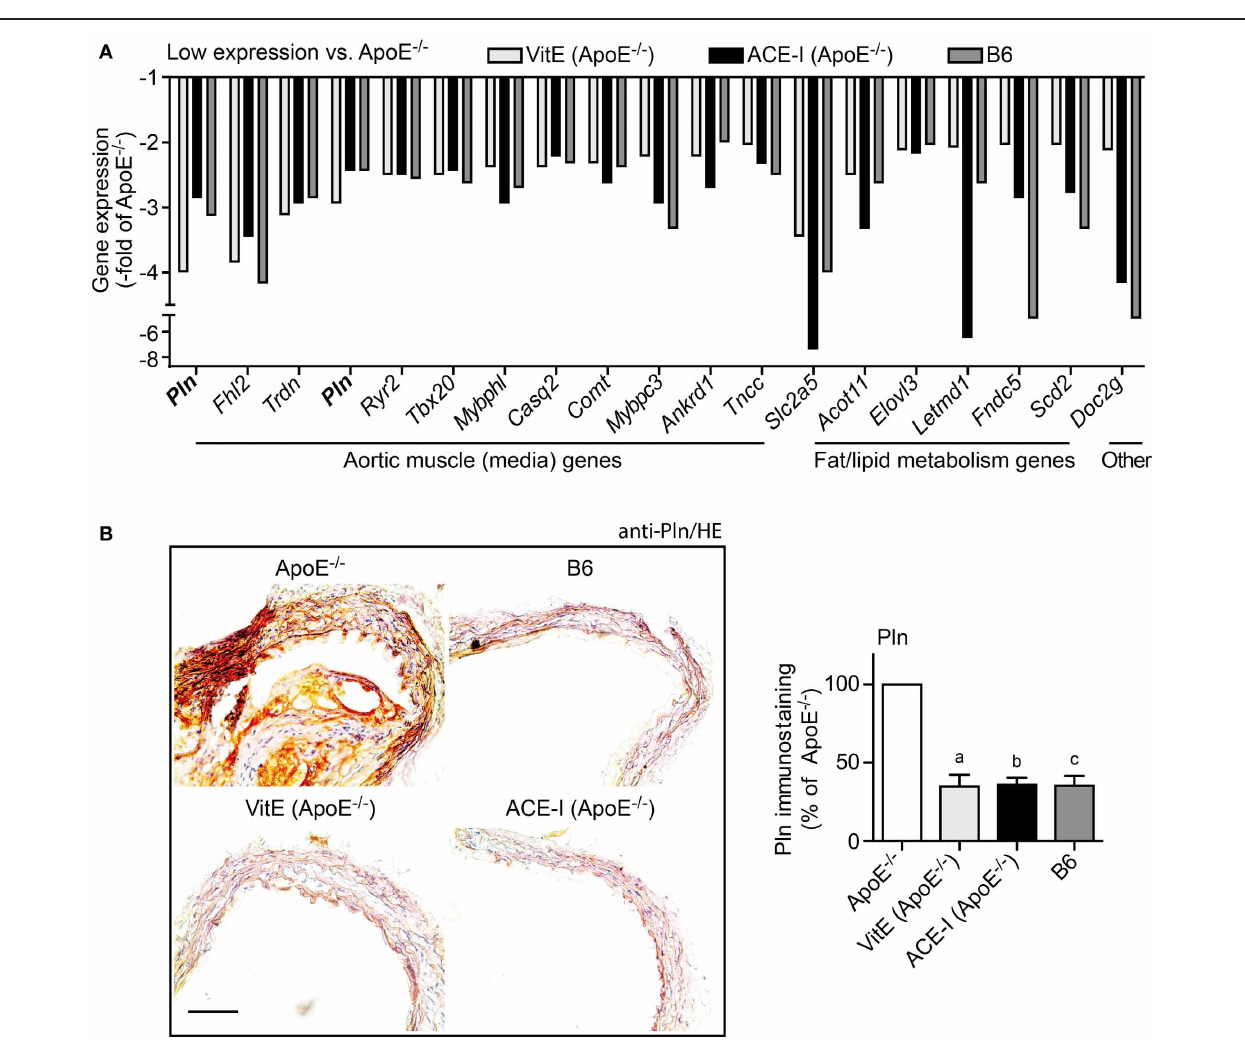
FIGURE 5 | Vitamin E and ACE inhibitor treatment preserved the contractile phenotype of the aortic media. (A) Microarray gene expression data of concordantly regulated genes with low expression in vitamin E-treated (VitE) and ACE inhibitor-treated(ACE-I) ApoE − / − aortas ( ≤− 2-fold lower signal intensity than that of untreated ApoE − / − aortas; P ≤ 0 . 01) and normalization toward B6 control level. GO analysis classified the majority of those genes with low expression as aortic muscle genes of the aortic media, which indicates that vitamin E and ACE-inhibitortreatment could prevent the atherosclerosis-related transition of the contractile phenotype of aortic smooth muscle cells to the synthetic phenotype.